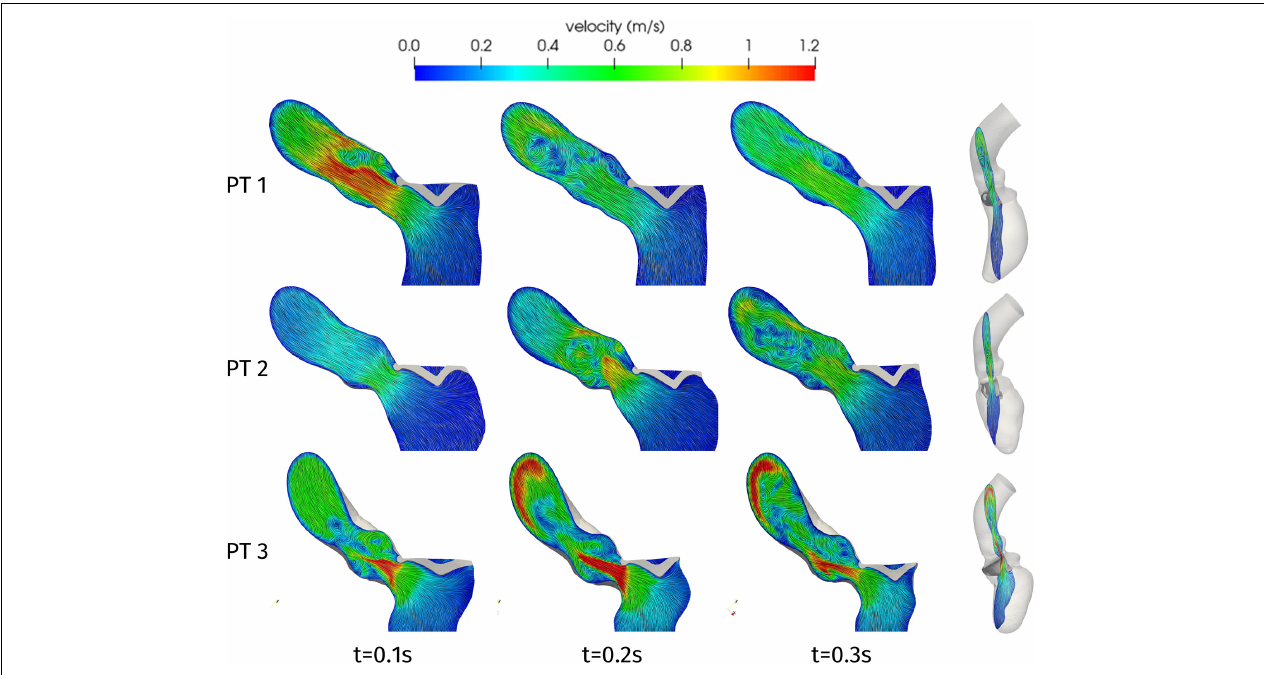
FIGURE 6 | Velocity distributions on a two-dimensional slice of the LV and ascending aorta, orthogonal to the latero-lateral axis of the LV (as shown on the right), at significant times during systole.